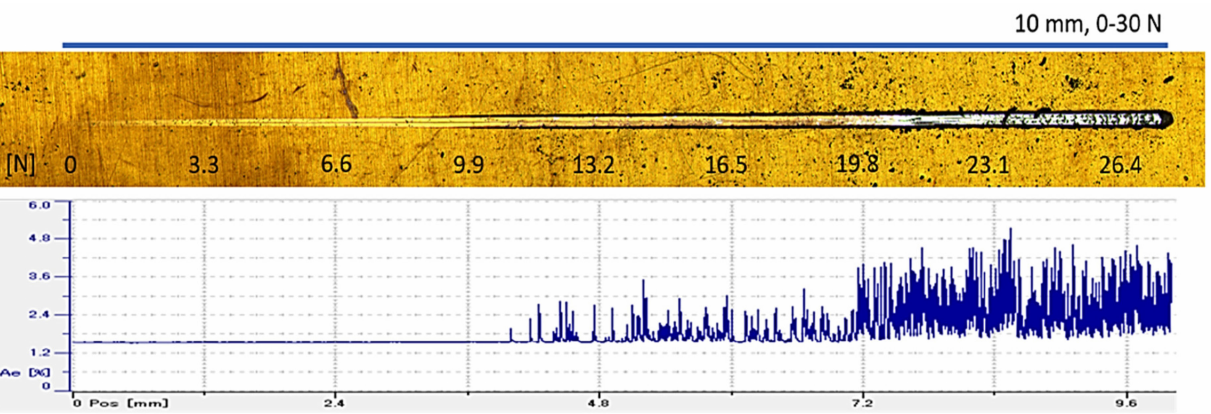
Figure 9. Measured width of the scratch (0–10 mm) and scratch test progressive load (0–30